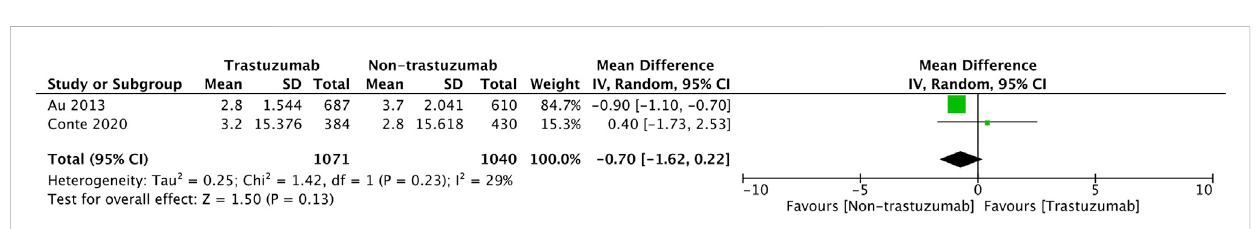
FIGURE 5 Pooled analysis of the difference in mean change from baseline of HRQoL after 12 months of follow-up based on RCTs.